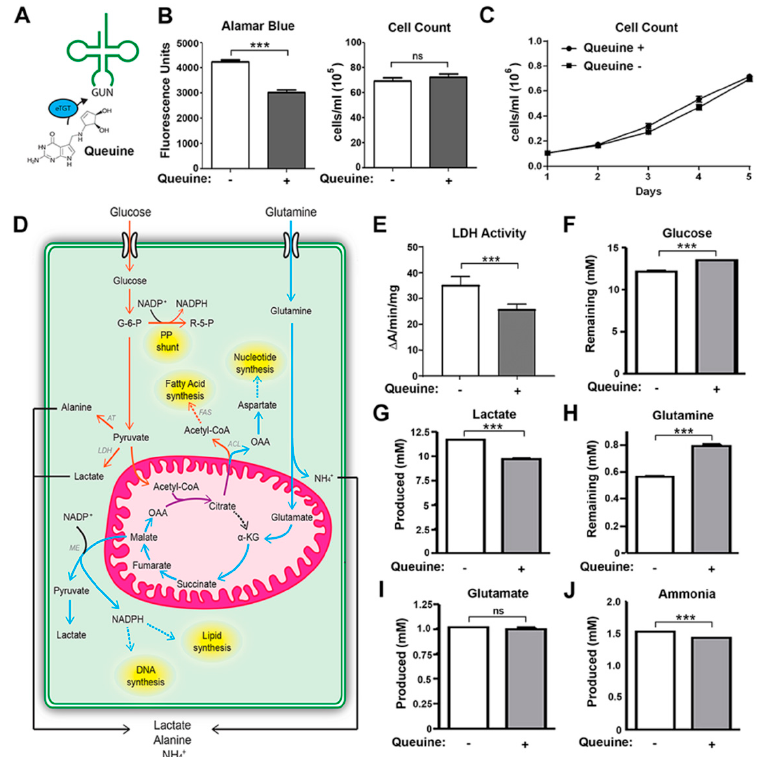
Figure 1. HeLa cells deficient in queuine experience a Warburg type metabolism. ( A ) The eukaryotic TGT (eTGT) enzyme irreversibly replaces guanine with queuine base in the wobble position of nuclear and mitochondrial tRNA containing a G 34 U 35 N 36 anticodon (where N is any nucleotide). ( B ) Cells were seeded at 3 × 10 4 per cm 2 in serum free medium (queuine deficient) for 5 days or supplemented with 1 μ M queuine base every 24 h. Viability and cell number were determined by Alamar blue assay and manual counting on a hemocytometer, respectively. ( C ) Queuine deficiency does not lead to changes in the rate of HeLa cell proliferation. Cells were grown as described above and counted daily using a hemocytometer. (D) Warburg metabolism is characterized by increased aerobic glycolysis. Glucose and glutamine supply the majority of carbon, nitrogen, free energy, and reducing equivalents required for cancer cell growth and division, with the concomitant secretion of lactate, alanine, and ammonia. Glucose may be redirected towards the pentose phosphate (PP) shunt for NADPH and ribose production. Acetyl-CoA from glucose and oxaloacetate (OAA) from glutamine converge to produce citrate, which is exported to the cytoplasm and converted to fatty acids through the action of the ATP-citrate lyase (ACL) and fatty acid synthase (FAS). Oxaloacetate may also be converted into aspartate to support nucleotide synthesis. Malate is exported to the cytoplasm where it is converted to lactate by malic enzyme (ME) and in the process produces NADPH necessary for the synthesis of lipids and DNA. Pyruvate is converted to lactate by the enzyme lactate dehydrogenase (LDH) and to alanine by alanine transaminase (AT), which is secreted from the cell. ( E ) HeLa cells were cultured for 48 h in serum-free medium in the absence (white bar) or presence (gray bar) of 1 μ M queuine. Total protein was extracted and LDH activity determined per mg of protein. ( F–J ) Cells were grown in serum free medium without further additions (white bar) or supplemented daily (gray bar) with 1 μ M queuine. At 72 h, the culture medium was filtered and the indicated substrates and metabolites quantitated using a Nova Bioprofile 400 analyzer. Mean (± s.d.) for triplicate samples. n ≥ 2. *** p < 0.001, t -test.